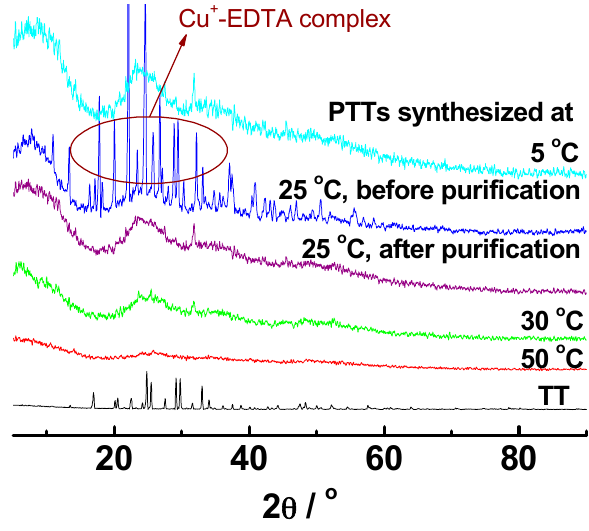
Figure 3. Wide-angle X-ray diffraction (WAXD) diffractograms of the TT monomer and PTT polymers prepared with a CuCl 2 /TT molar ratio of 1.0 and a TT concentration of 0.38 mol·L − 1 in DMF for 24 h.